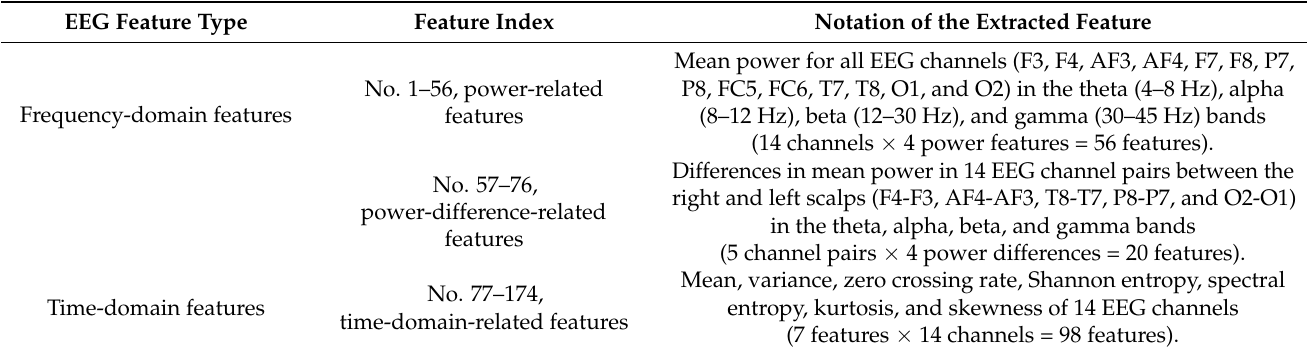
Table 2. Feature extraction methods for comparison models.